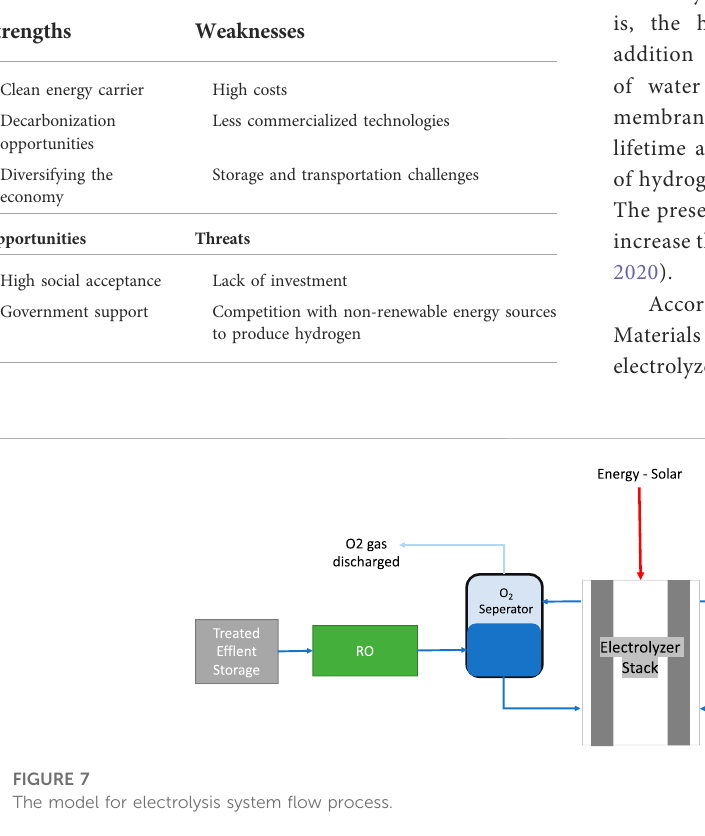
TABLE 3 SWOT analysis for hydrogen production.